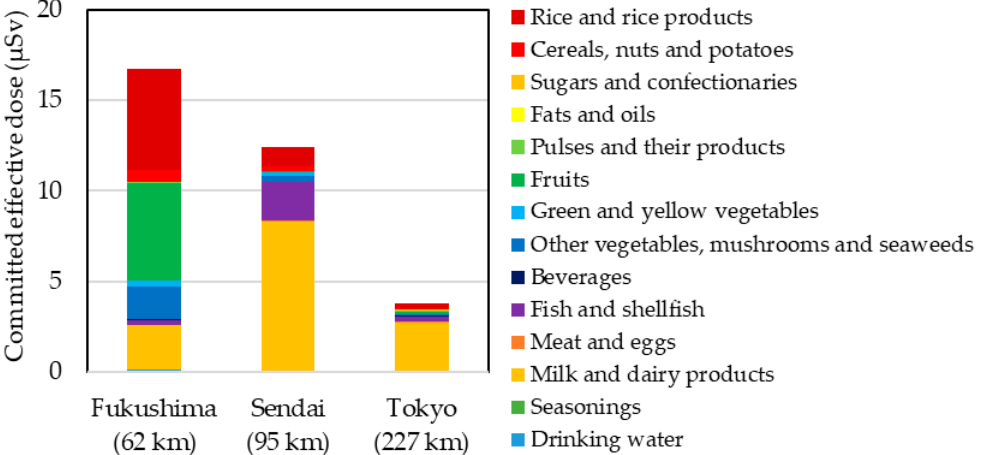
Figure 3. Committed effective doses of radioactive cesium ( 137 Cs + 134 Cs) by food groups in 2011. Distance from the Fukushima Daiichi nuclear power plant to each city is denoted in parentheses. This figure was modified from [19].